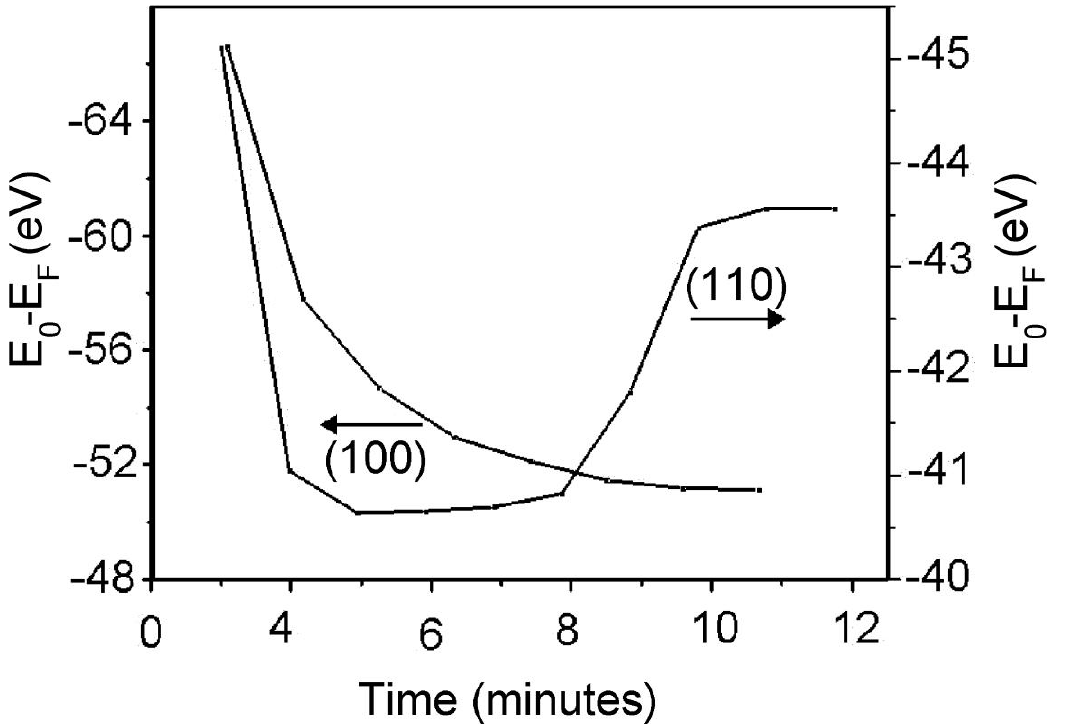
Figure 10. The change of the magnitude of the apparent O 2 s binding energy, with time, indicative of the surface photovoltaic charging of the Li following a temperature increase to 390 K compared to the Li following a temperature increase to 420 K. Adapted from [5].